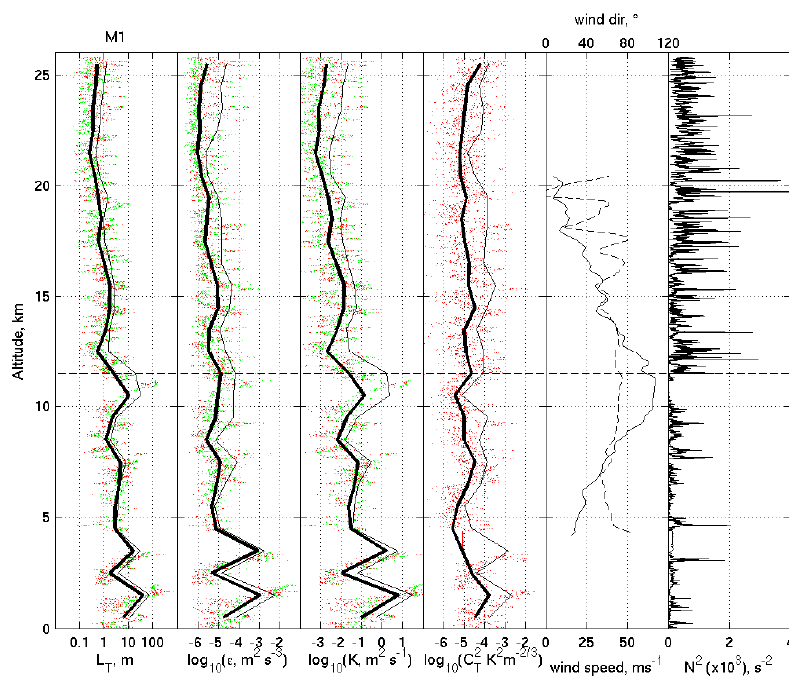
Fig. 5. Vertical distributions of turbulence parameters (from left to right): Thorpe length L T , energy dissipation rate ε , diffusivity K , temperature structure constant C 2 with their median (thick solid lines) and mean (thin solid lines) values for segments of 1km in thickness, wind speed (solid line) and direction (dashed line) and squared Br¨unt-V¨ais¨al¨a frequency N 2 for flight M1. Both directly measured and estimated values of L T , ε , and K are shown with green and red dots, respectively. The horizontal dashed line shows the temperature gradient tropopause height.